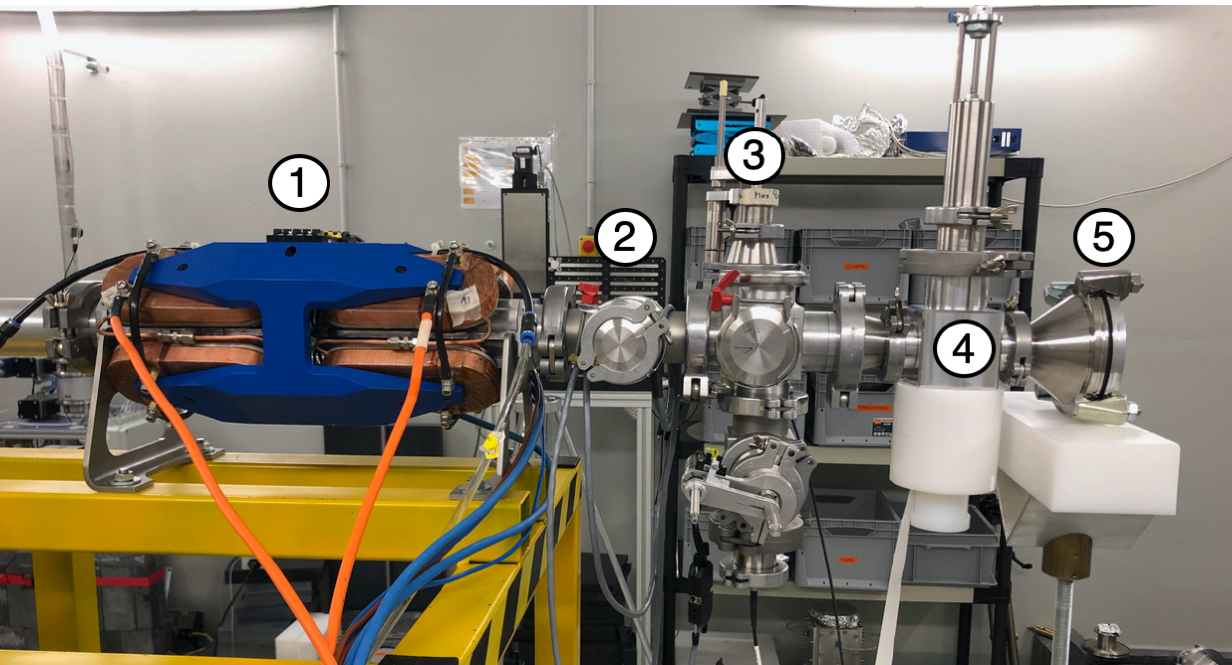
Figure 1. The Automatic Focusing System (AFS) under test in the Beam Transfer Line (BTL) bunker: (1) the Mini-PET Beamline (MBL); (2) drift space; (3) two-dimensional beam profile detector (UniBEaM); (4) π 2 detector (or, alternatively, two-dimensional UniBEaM detector or target station with current read-out); (5) beam